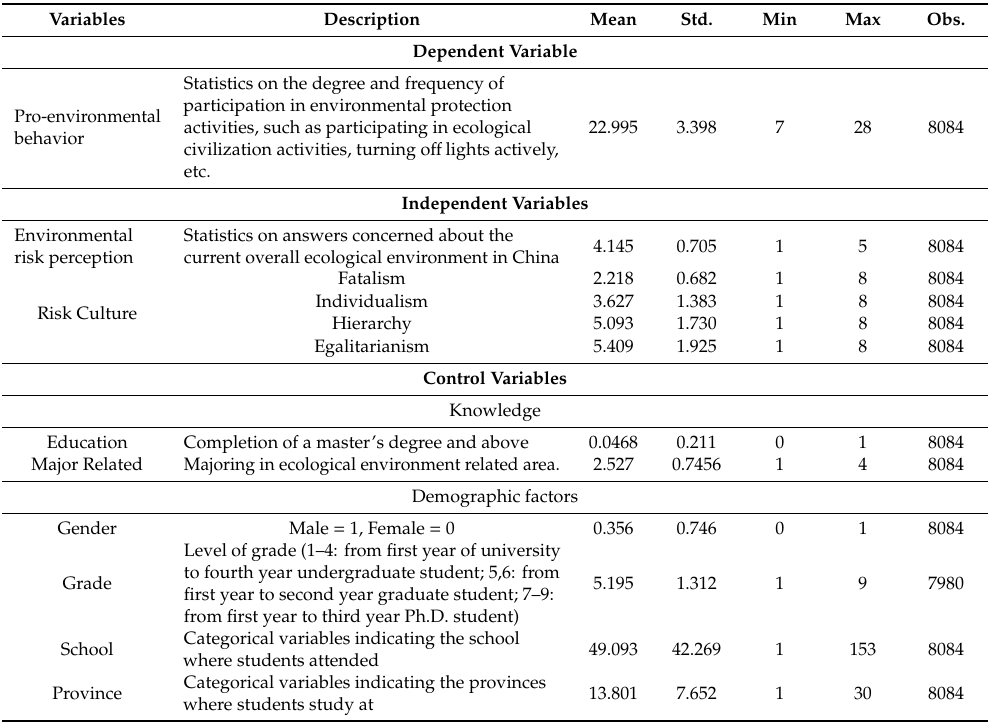
Table 3. Summary of